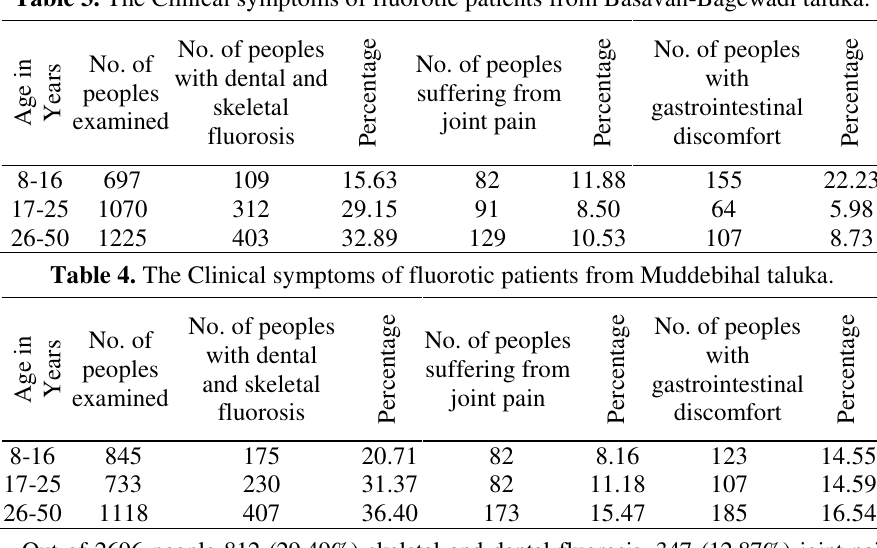
Table 3. The Clinical symptoms of fluorotic patients from Basavan-Bagewadi taluka.